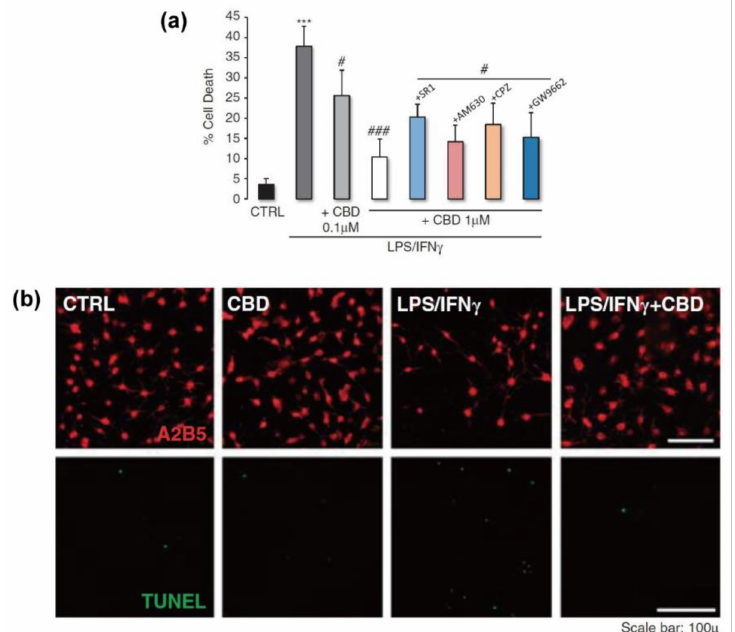
Figure 6. CBD actions on OPCs. ( a ) Protective effect of CBD on LPS/IFN γ -induced cytotoxicity in OPCs. CB1, CB2, TRPV1, or PPAR γ antagonists (SR1, AM639, CPZ: 1 mM and GW9662: 50